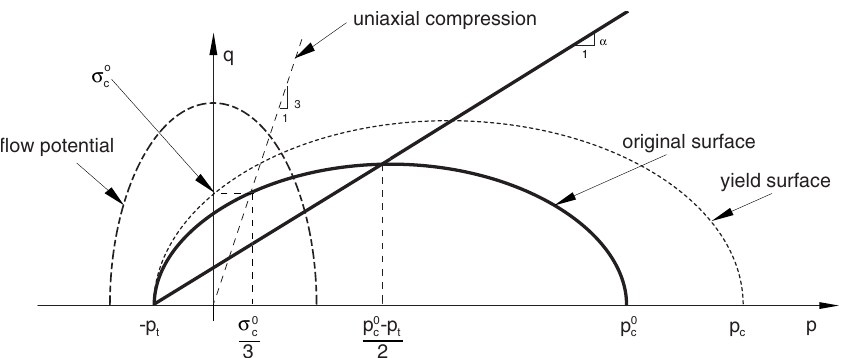
Figure 2. Crushable foam model with volumetric hardening: yield surface and flow potential in the Figure 19.3.5–1 Crushable foam model with volumetric hardening: p - q stress plane (adapted from [54]). yield surface and fl ow potential in the p – q stress plane.